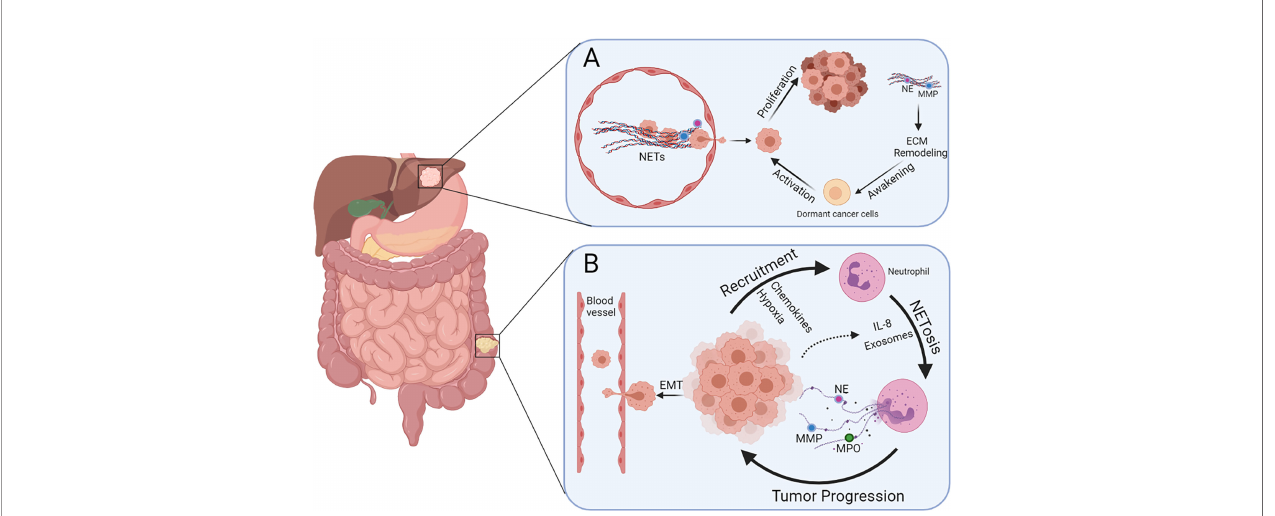
FIGURE 2 | Multiple functions of NETs during colorectal cancer liver metastasis. (A) NETs present in blood vessels can entrap cancer cells and promote extravasation. Dormant cancer cells in the liver can be awakened via NET-induced ECM remodeling and hence promote metastasis and recurrence. (B) Neutrophils can be recruited by CRC cells because of the presence of chemokines and hypoxia in the tumor microenvironment, leading to more NETosis triggered by IL-8 and exosomes released by cancer cells. Cancer cells undergoing EMT are more prone to intravasate after stimulation of